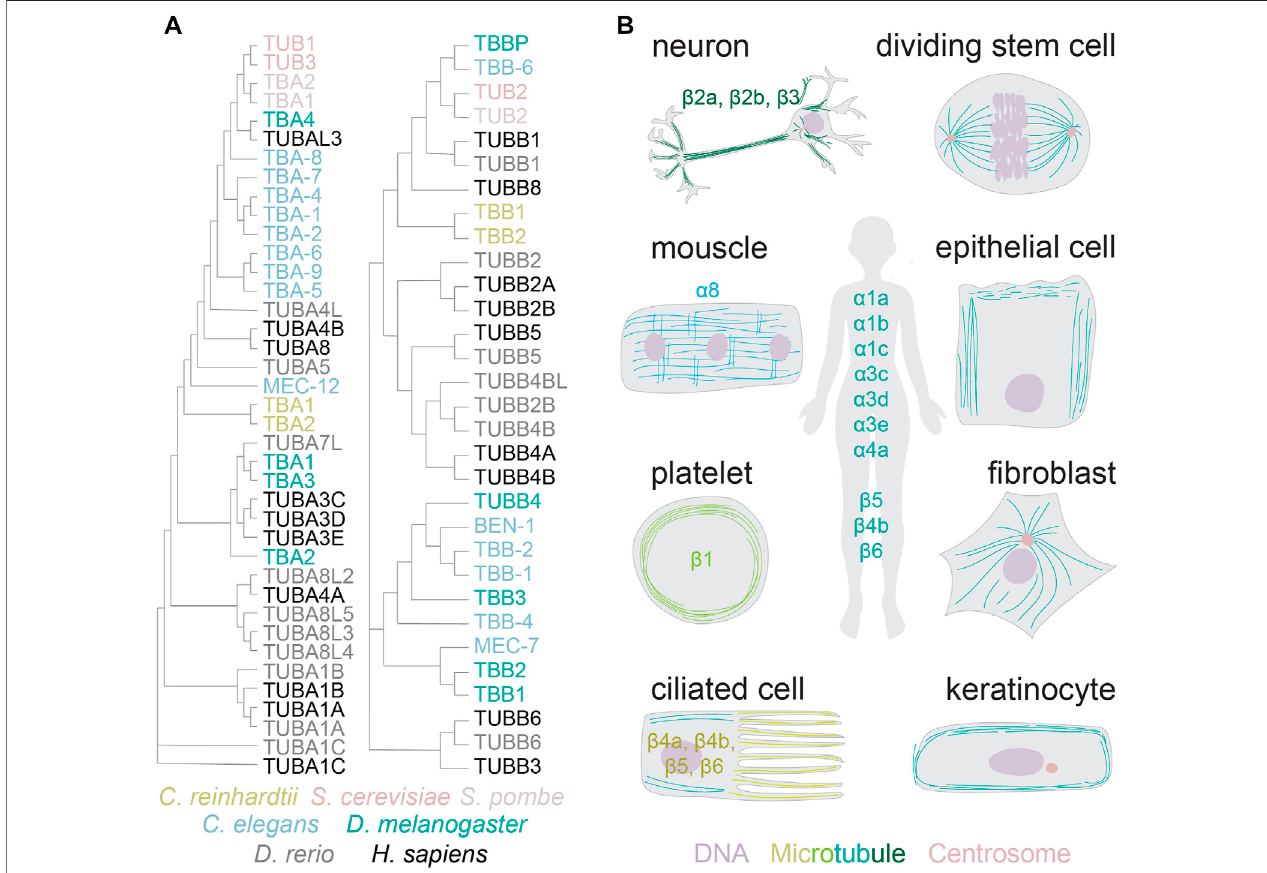
FIGURE 1 | Tubulin gene networks and protein distribution. (A) Phylogenetic neighbour-joining tree without distance corrections (with cladogram branch length, created with Clustal Omega). Color coded are tubulins from the species referenced in this review article. (B) The distribution of tubulin isotypes and diversity of microtubule architectures across specialized cells in higher